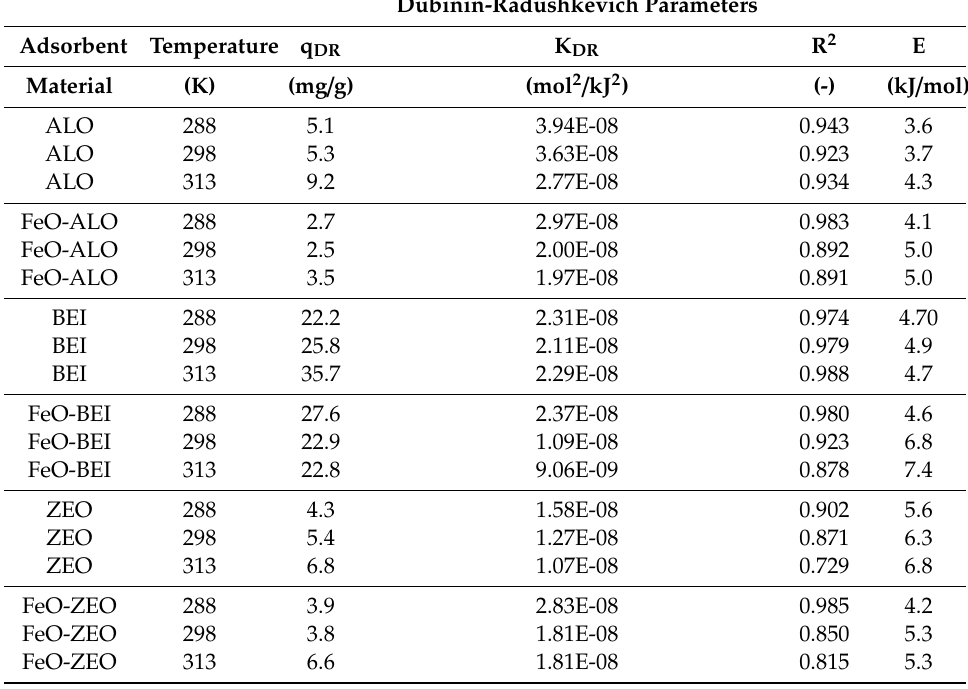
Table 5. Summary of the Dubinin–Radushkevich parameters and mean free energy changes (E) of the adsorption of aqueous Ba 2 + by ALO, BEI and ZEO with (out)